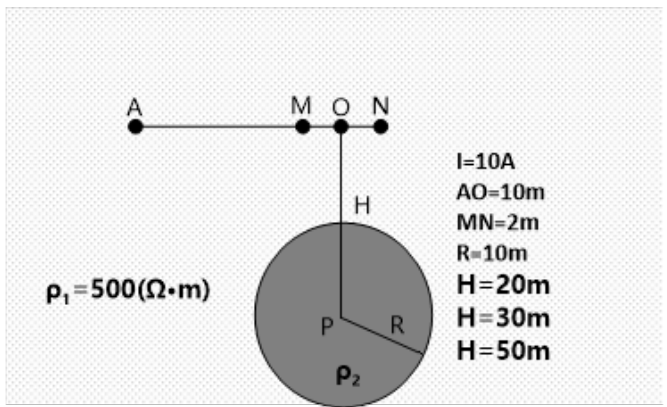
Figure 8. Schematic diagram of the calculation model.